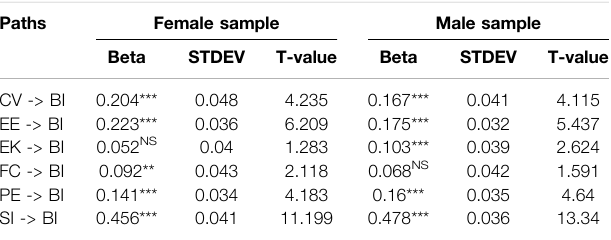
TABLE 6 | Bootstrapping results for PLS-MGA.